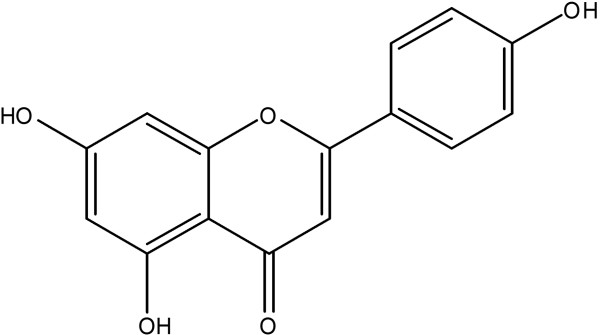
Chemical structure of apigenin: 5, 7-dihydroxy-2-(4-hydroxylphenyl)-4H –chromen-4-one, C15H10O5, MW: 270.24.